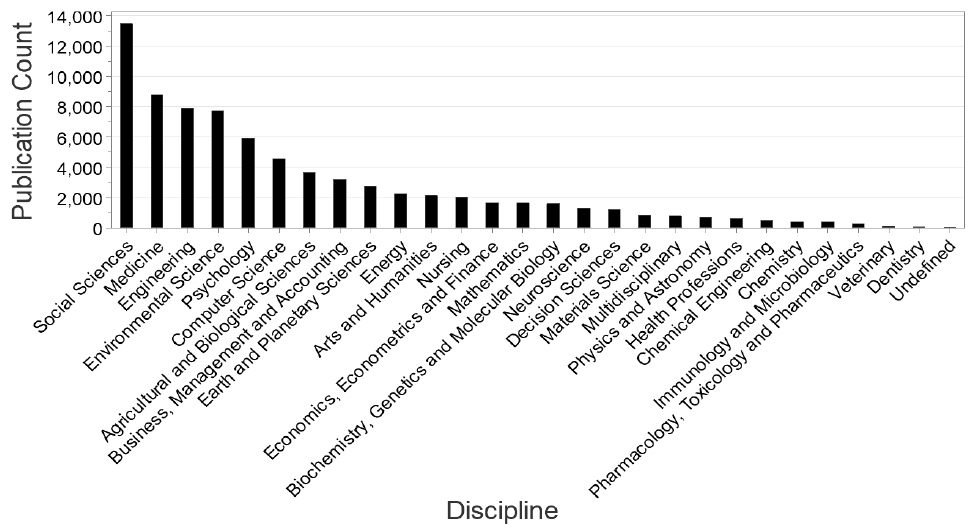
Figure 2. Publication counts listing resilience in their titles. Data source: [13].